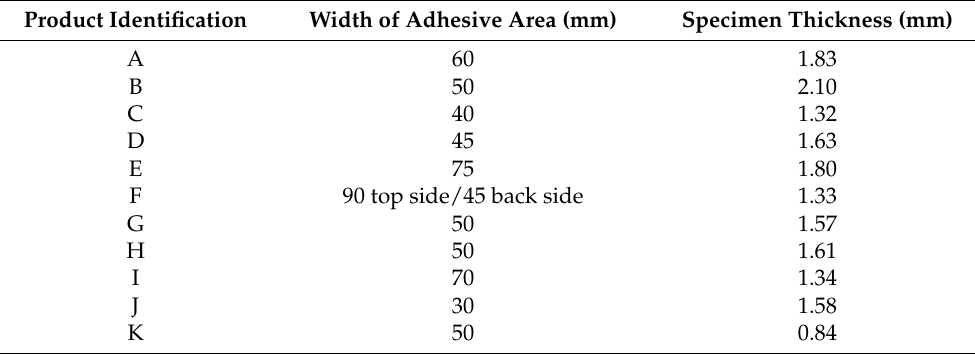
Table 1. Overview of Tested Products (Brand Names Have Been